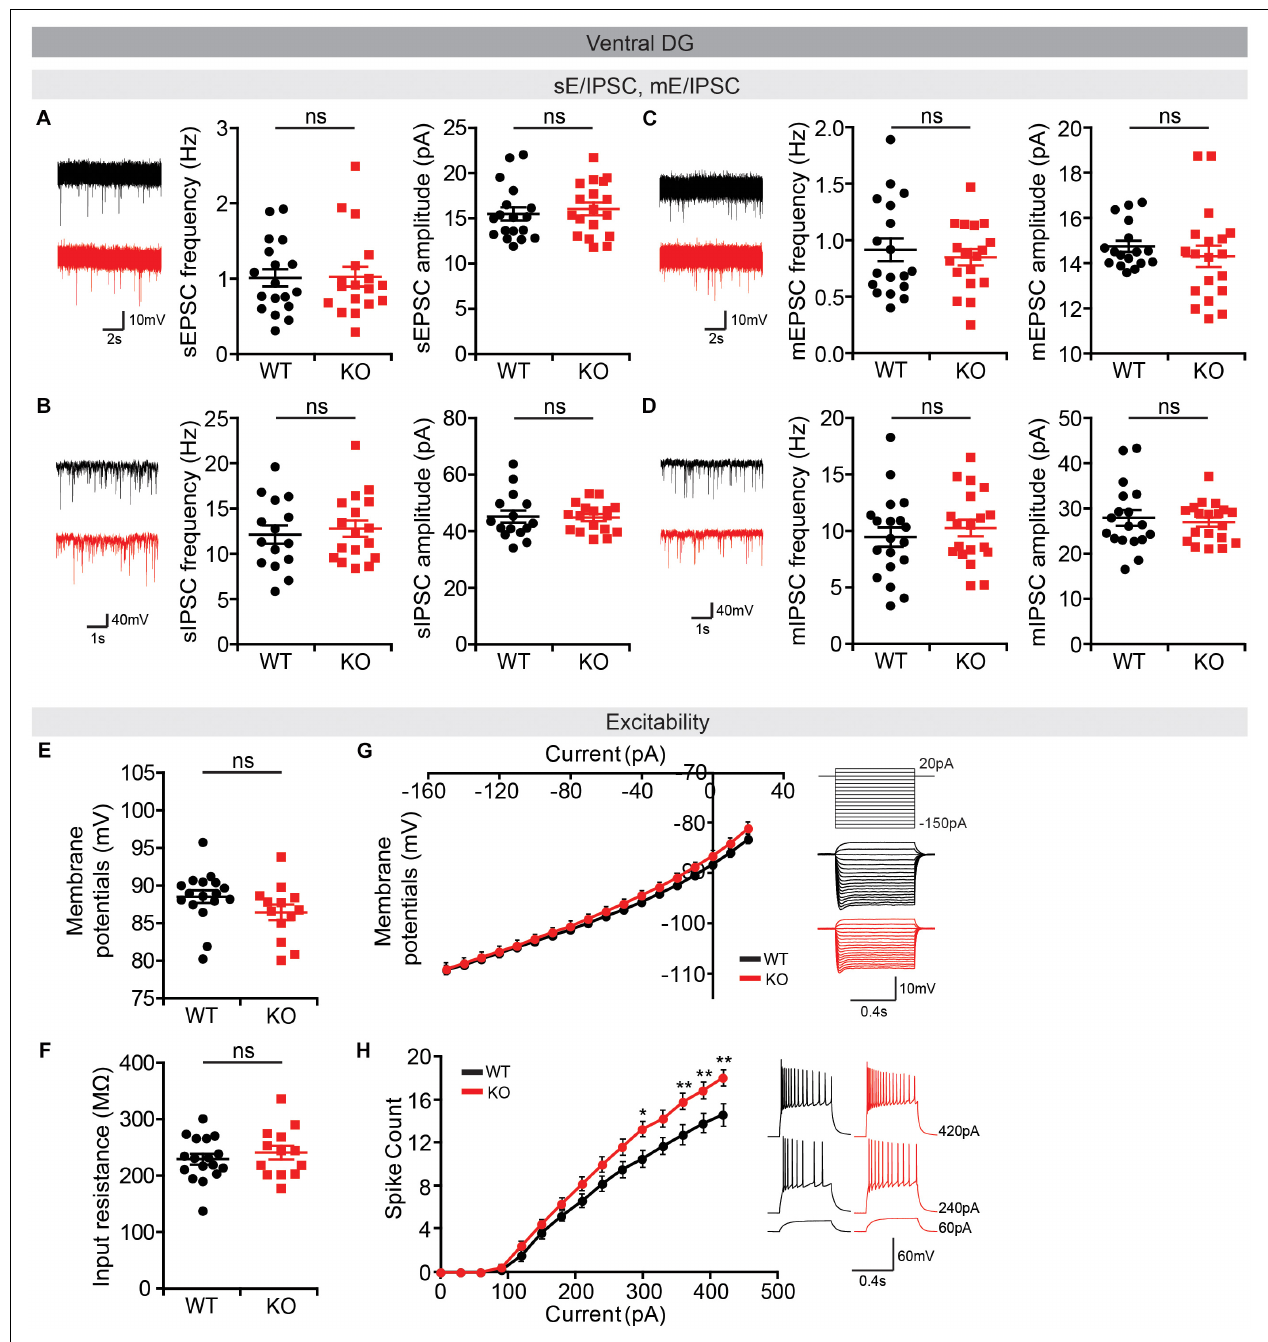
FIGURE 9 | Normal synaptic transmission but increased intrinsic excitability in Lrrc4c − / − vDG neurons. (A,B) Normal sEPSCs and sIPSCs in vDG neurons in the hippocampus of Lrrc4c − / − mice (2–4 months). n = 18 (3) (WT), n = 18 (3) (KO) (sEPSC), n = 15 (3) (WT), n = 17 (3) (KO) (sIPSC), ns, not significant, Student’s t -test [(A) sEPSC amplitude: t ( 34 ) = 0.5486, p = 0.5869; sEPSC frequency: t ( 34 ) = 0.0886, p = 0.9299; (B) sIPSC amplitude: t ( 30 ) = 0.1498, p = 0.8819; sIPSC frequency: t ( 29 ) = 0.7358, p = 0.4677]. (C,D) Normal mEPSCs and mIPSCs in vDG neurons in the hippocampus of Lrrc4c − / − mice (2–4 months). n = 18 (4) (WT), n = 19 (4) (KO) (mEPSC), n = 18 (3) (WT), n = 19 (3) (KO) (mIPSC), ns, not significant, Mann–Whitney test, Student’s t -test [(A) mEPSC amplitude: U = 130.5, p = 0.3340; mEPSC frequency: t ( 34 ) = 0.5379, p = 0.5942; (B) mIPSC amplitude: U = 166.5, p = 0.8987; mIPSC frequency: t ( 36 ) = 0.7231, p = 0.4743]. (E–H) Increased intrinsic neuronal activity in vDG neurons in the hippocampus of Lrrc4c − / − mice (2–4 months), as shown by increased current-firing curve, although resting membrane potential and input resistance are normal. n = 17 (4 mice) (WT), n = 13 (3) (KO), ∗ p < 0.05, ∗∗ p < 0.01, ns, not significant, Student’s t -test, two-way repeated measures ANOVA with Holm-Sidak multiple comparison test [ (E) t ( 28 ) = 1.3, p = 0.2041; (F) t ( 28 ) = 0.7744, p = 0.4452; (G) interaction, F ( 17 , 476 ) = 1.644, p = 0.0501; genotype, F ( 1 , 28 ) = 0.69, p = 0.4132; current, F ( 17 , 476 ) = 1174, p < 0.0001; (H) interaction, F ( 14 , 280 ) = 5.189, p < 0.0001; genotype, F ( 1 , 20 ) = 5.058, p = 0.0359; current, F ( 14 , 280 ) = 504.9, p < 0.0001; 300 pA, p = 0.0198, 330 pA, p = 0.0380, 360 pA, p = 0.0049, 390 pA, p = 0.0069, 420 pA, p =